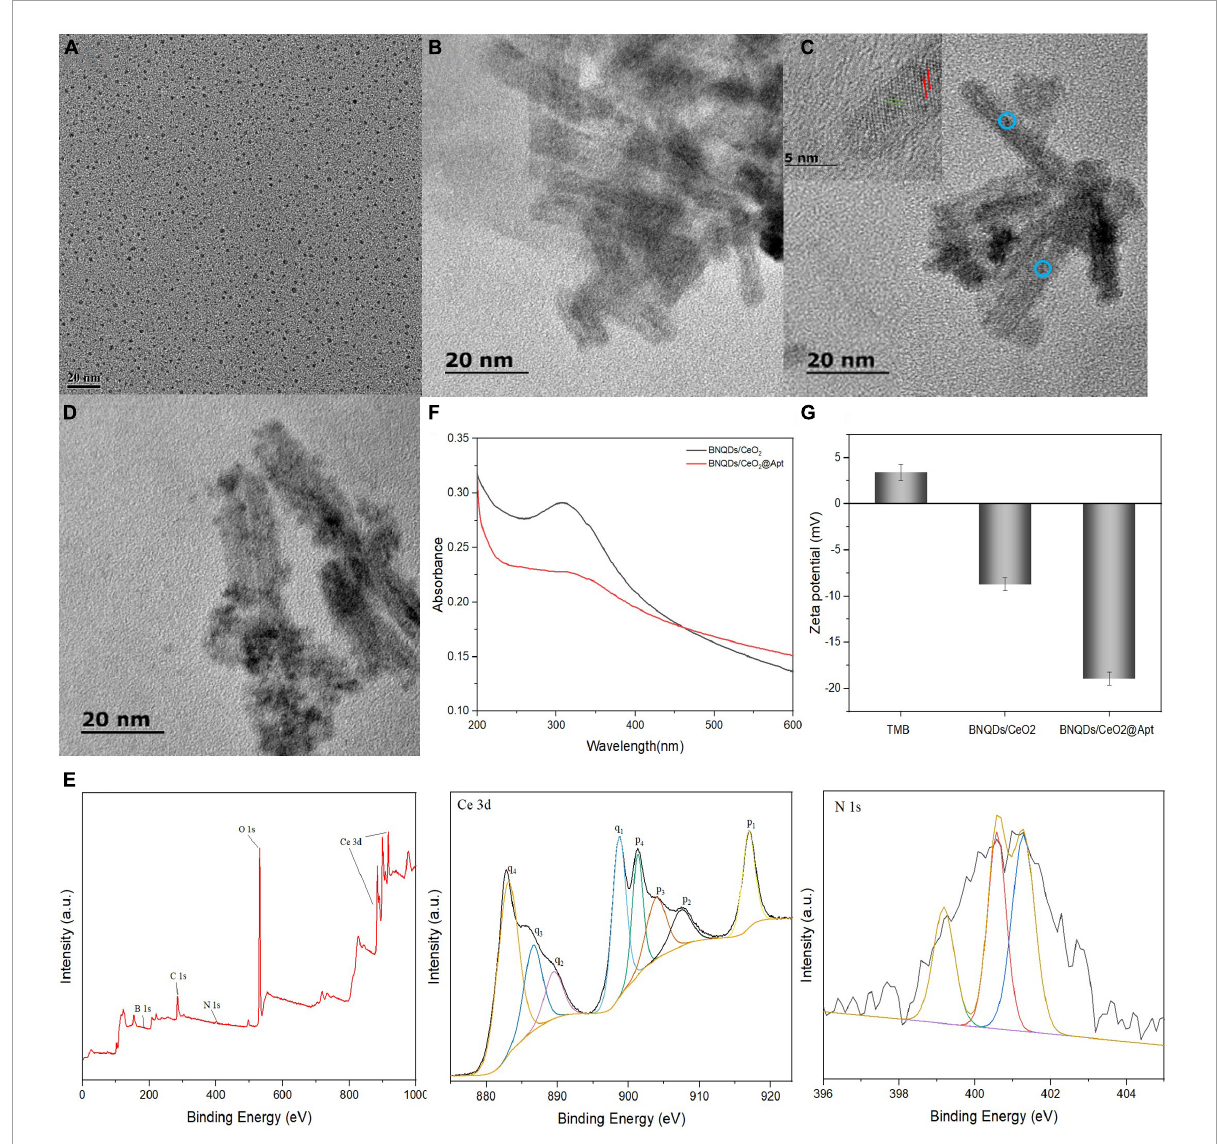
FIGURE4 Transmission electron microscopy (TEM) image of (A) BNQDs; (B) CeO 2 /Ce(OH) 3 nanorod precursor; (C) BNQDs/CeO 2 ; (D) BNQDs/CeO 2 @Apt; (E) XPS survey spectrum of BNQDs/CeO 2 , and high-resolution XPS spectra of Ce 3d, and N 1s; (F) UV-Vis absorption spectra of BNQDs/CeO 2 and BNQDs/CeO 2 @Apt; (G) Zeta potential of TMB, BNQDs/CeO 2 , and BNQDs/CeO 2